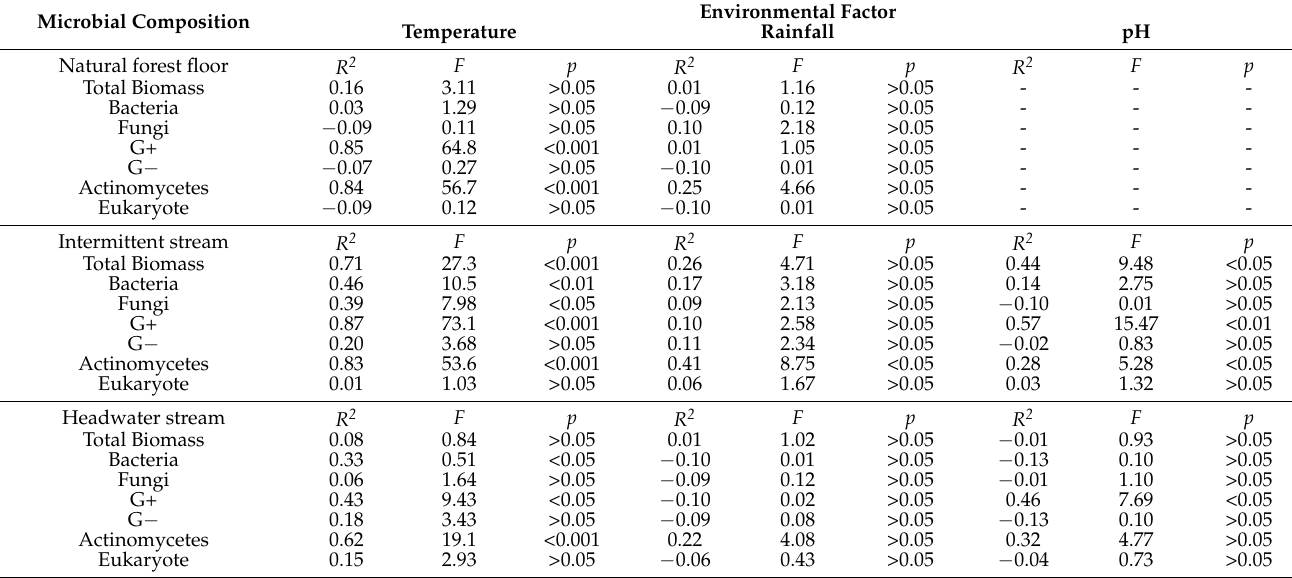
Table 2. Linear regression for three habitats between environmental factors (Temperature, Rainfall, pH, Flow rate) and the concentrations of microbial